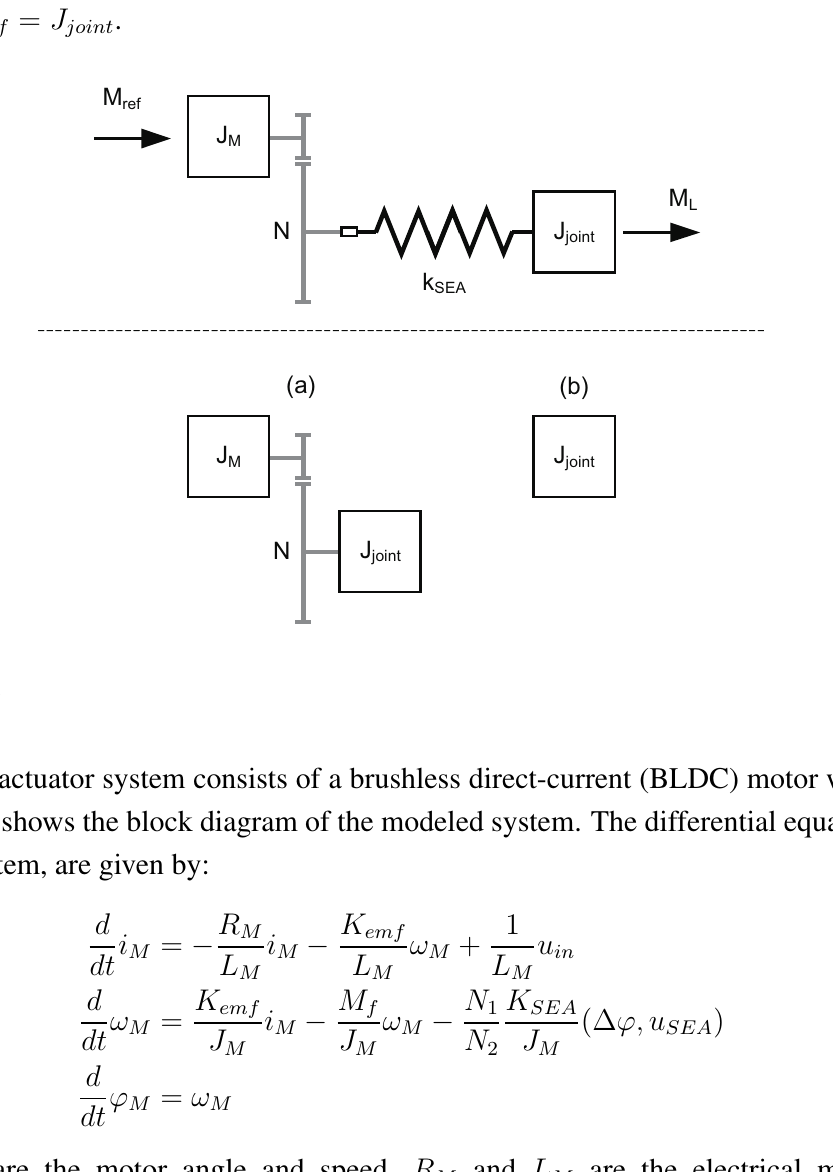
Figure 1. The principle of a compliant actuator with the typical setting of the gearbox reduction (top); ( a ) the high frequency approximation of the effective inertia at the joint J = J + N 2 J ; and ( b ) the low frequency approximation of the effective inertia at eff joint M = J the joint J eff joint